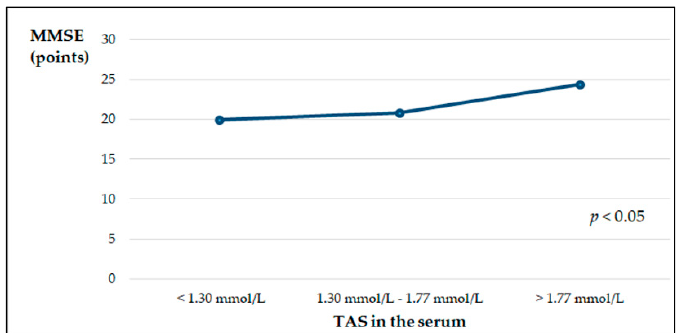
Figure 2. MMSE point scale depending on TAS in the serum of patients with AD, estimated by the ANOVA Kruskal–Wallis test.